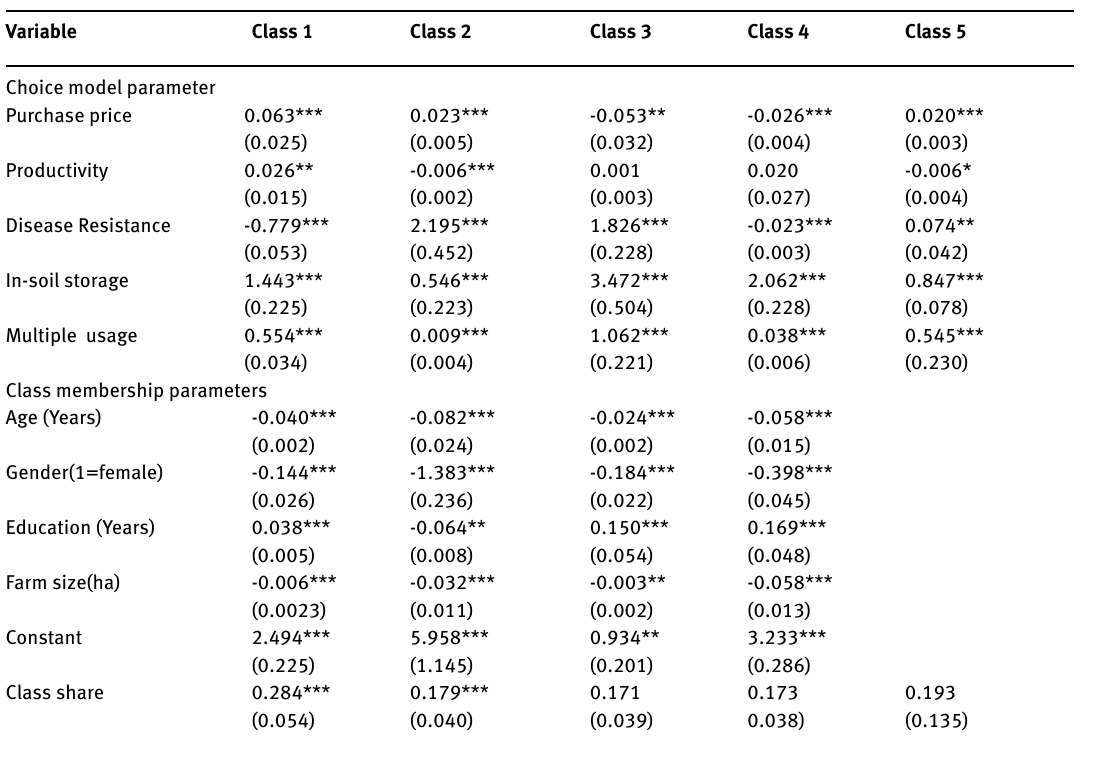
Table 7: LCM estimation results for five latent classes Variable